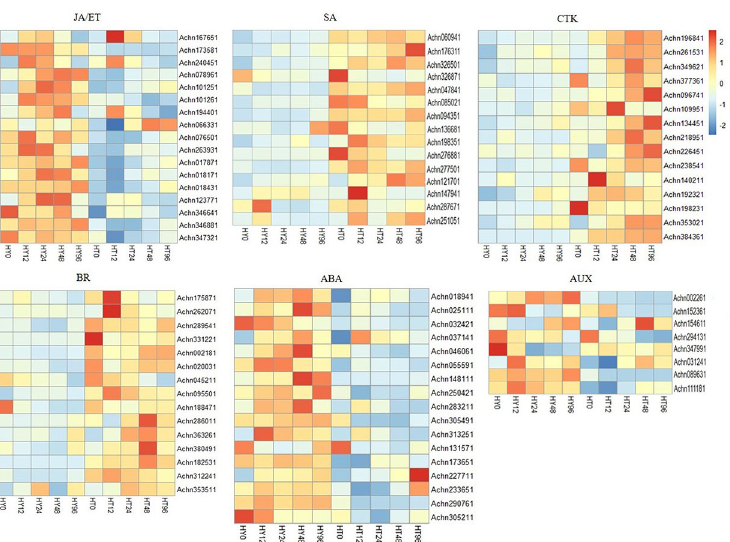
Fig 8. An overview of phytohormone signaling pathways after Psa inoculation, including the SA, JA, ET, AUX, CTK, BR, and ABA signaling pathways. Gene expression level was measured using the FPKM method (expected number of fragments per kilobase of transcript sequence per millions of base pairs sequenced). Horizontal axes represent gene ID and vertical axes represent 0, 12, 24, 48, and 96 hai (from left to right) with Psa in Hongyang (HY) and Huate (HT). Expression patterns of the DEGs range from blue (low expression) to red (high